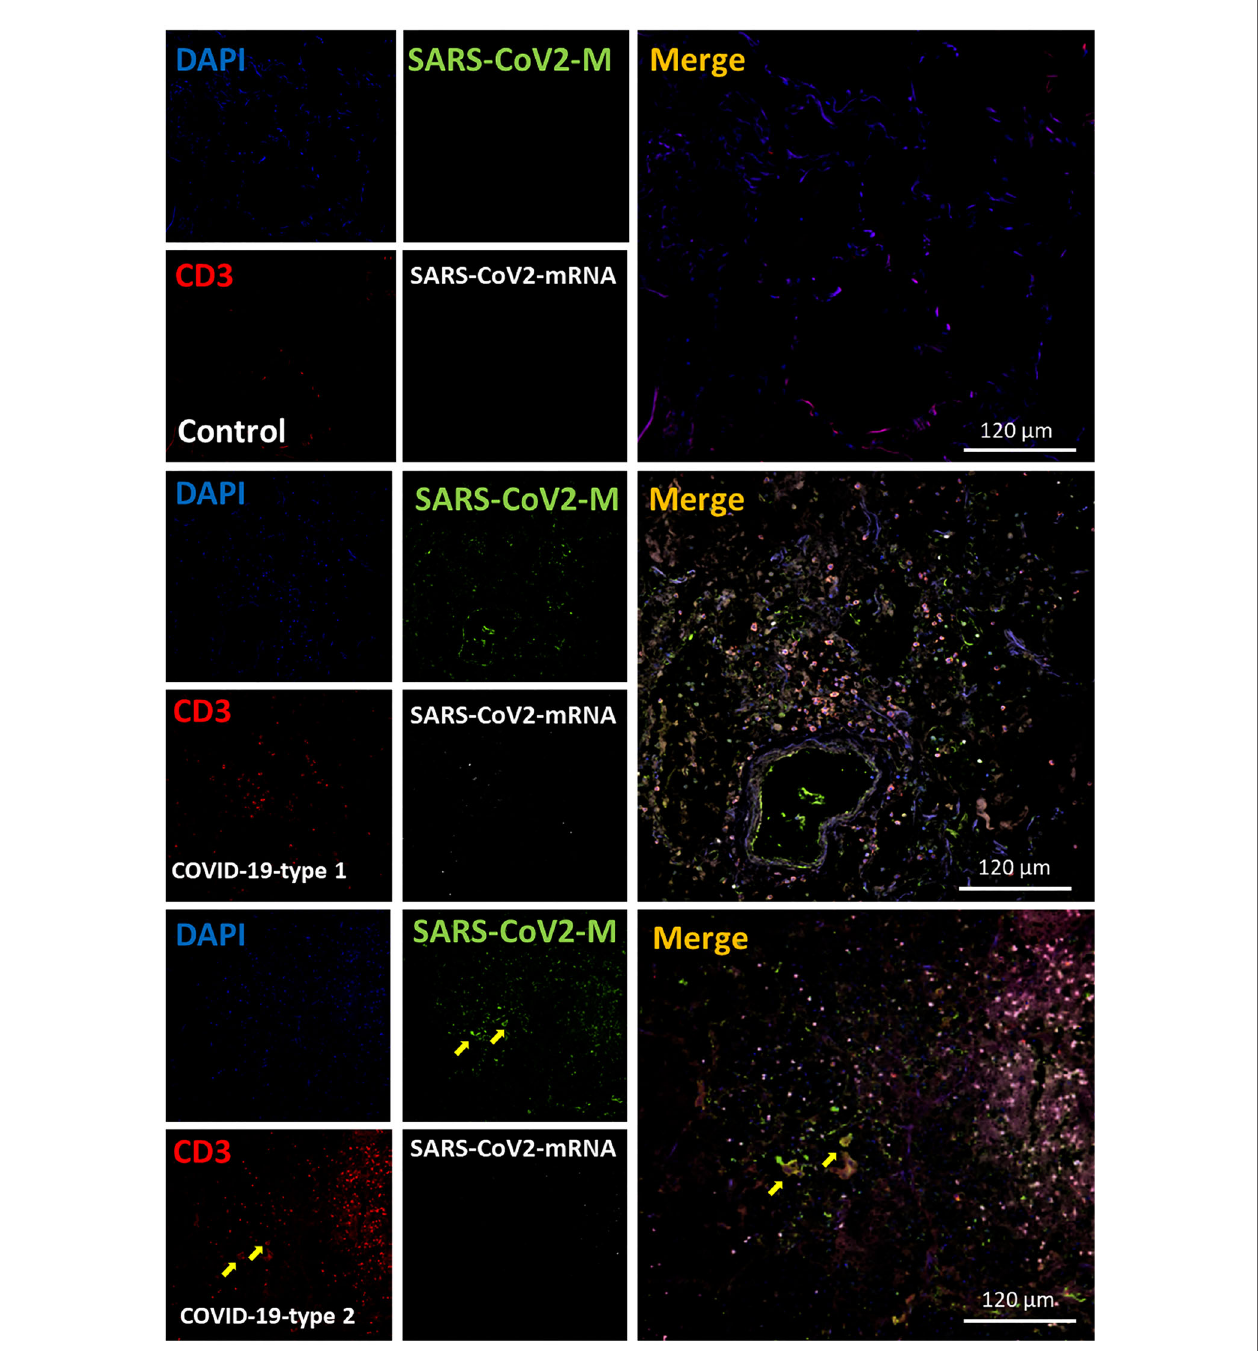
FIGURE 6 | COVID-19 disease induces a small but signi fi cant in fi ltration of CD3 lymphocytes into the lung. Staining for nuclei (DAPI, blue staining), SARS-CoV-2 protein M (SARS-CoV-2-M, green staining), CD3 lymphocytes (CD3, red staining), and SARS-CoV-2-mRNA (White staining) was performed. 3D reconstructions of lung samples collected from uninfected (control) and COVID-19 (Type 1 or 2, enhanced coagulation, and immune in fi ltration). In control conditions, lymphocytes were mostly randomly attached to the alveolar wall (Control). In contrast, in the enhanced coagulation phenotype (COVID-19, type I, damage), a signi fi cant in fi ltration of lymphocytes was observed (COVID-19-type 1), but most of this in fi ltration was localized, and most areas were negative for CD3 + cells. No CD3 + lymphocytes were positive for viral mRNA or the viral protein M. As indicated in the previous fi gure, most viral protein M staining was concentrated inside blood vessels (see yellow arrows). In the immune in fi ltrating phenotype, we observed a signi fi cant increase in lymphocyte in fi ltration, but as indicated above, in fi ltration was region-speci fi c, and most areas were negative for CD3 staining. (n = 13-15 different cases analyzed with a least fi ve sections